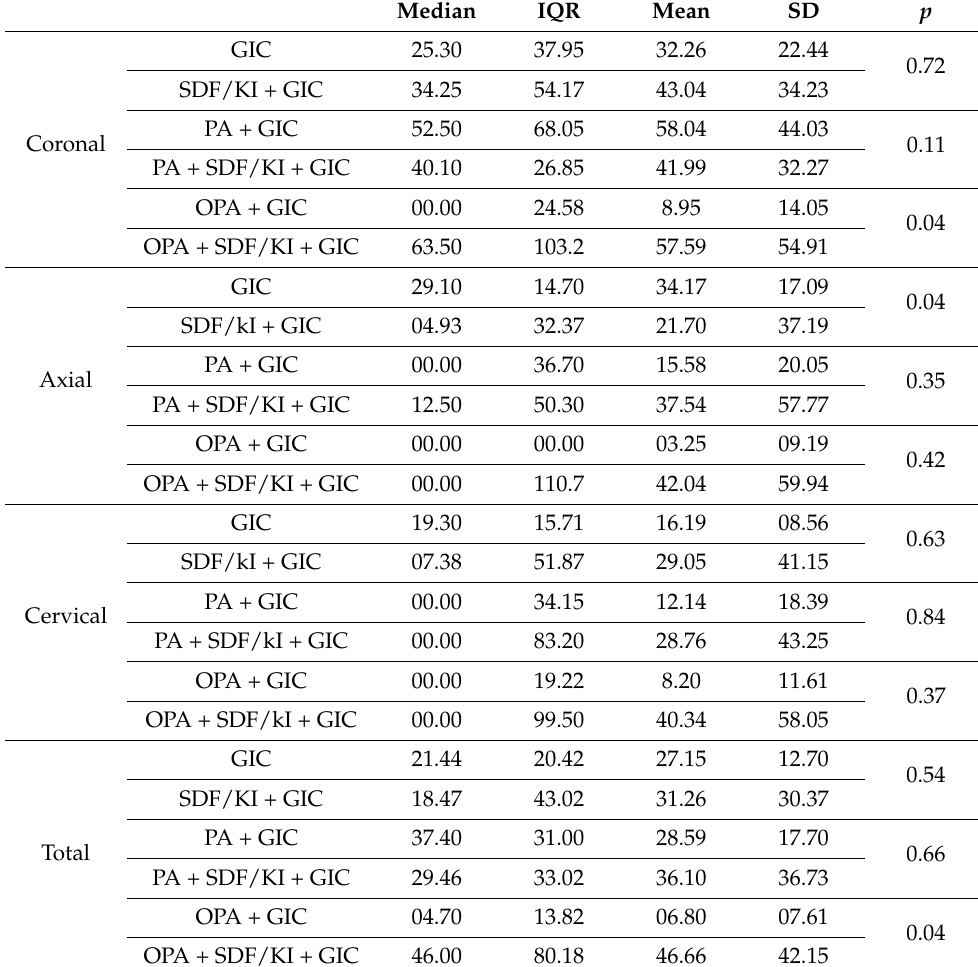
Table 3. Interfacial gap values in µ